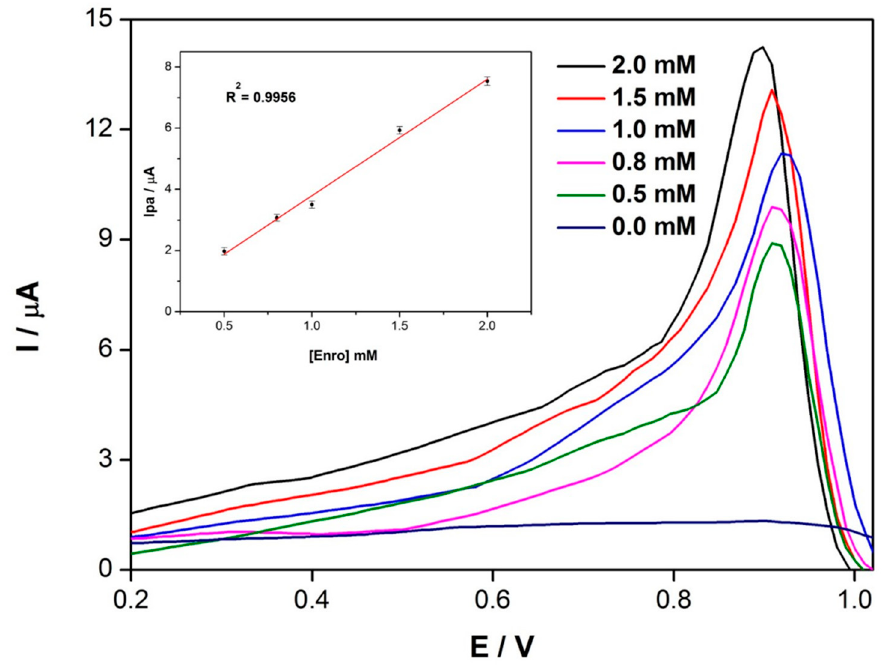
Figure 5. Square wave voltammetry (SWV). Enrofloxacin samples prepared at pH 3 at different con- centrations.